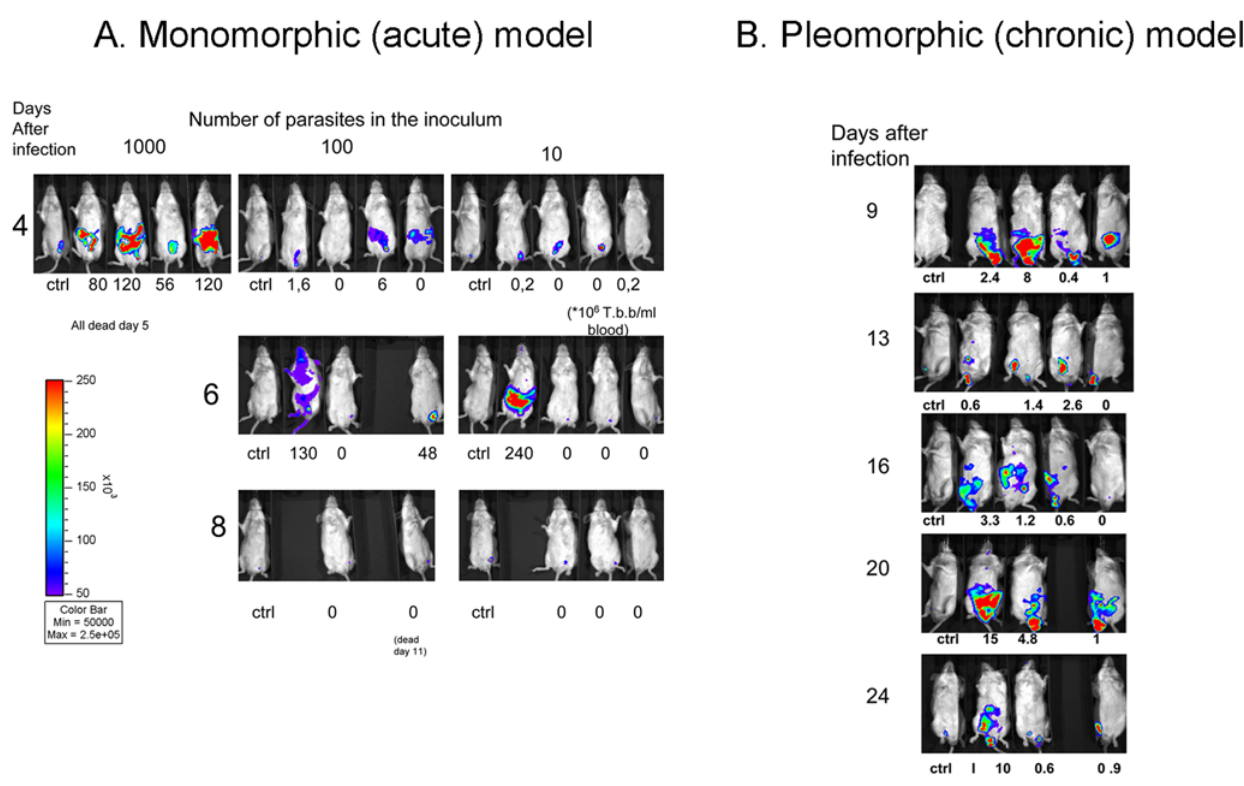
Figure 2. Invivo bioluminescence models. A. Dynamics of T.b. brucei Lister 427 infection in female BALB/c mice. Balb/c mice were infected i.p. with the indicated numbers of T.b. brucei lister 427. Coelenterazine was inoculated 3–5 minutes before light detection in an IVIS Imaging System. This procedure was repeated at different days after infection. A non infected mouse is included as a control on the left of each image set. Color scales indicate photon emission (photons s 2 1 cm 2 2) during a 180-s exposure. The parasitemia levels of individual mice at the specific time points are also indicated ( 6 10 6 /ml). B. Dynamics of T.b. brucei AnTat 1.1 infection visualized by bioluminescence imaging. Parasite load in BALB/c male mice injected i.p. with 2 6 10 4 luciferase recombinant T.b. brucei AnTat 1.1 was assessed daily by biophotonic emission determination as indicated in material and